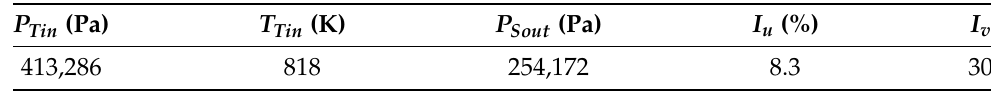
Table 3. Boundary conditions of the external gas stream.